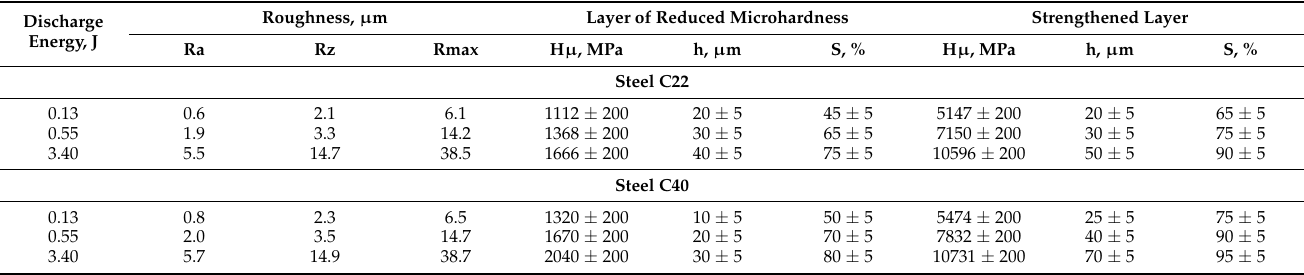
Table 2. Qualitative parameters of sulfomolybdenum coatings obtained by ESA method (S, %—layer continuity). Roughness, µ Discharge Energy, J